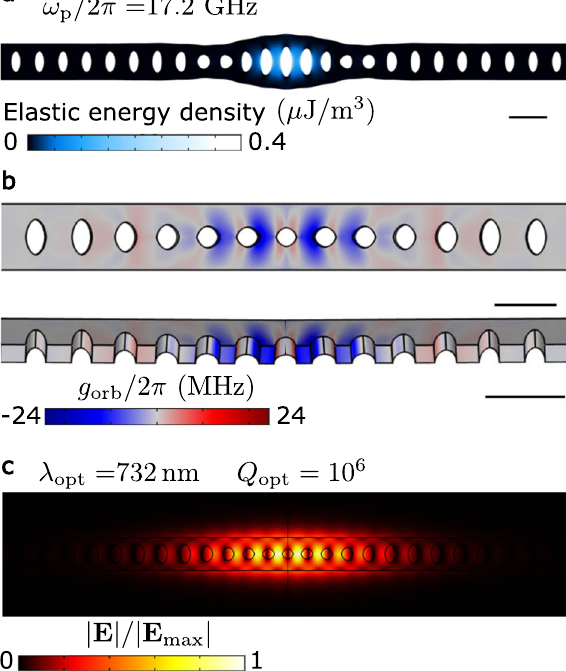
Fig. 3 Diamond optomechanical cavity. a Distribution of elastic energy density of a mode of the diamond cavity resonant at ω p /(2 π ) = 2 GHz. The cavity geometry is arti fi cially distorted along the coordinate of the mechanical mode for emphasis. The energy density is concentrated in the central part of the cavity. b Calculated coupling rate g orb in the phononic cavity. c Normalized amplitude of the optical electric fi eld at vacuum wavelength λ opt = 732 nm of an optical mode of the diamond cavity of an optical quality factor Q opt ≈ 10 6 . The electric fi eld is concentrated around the center of the cavity and thus overlaps with the regions providing high values of g orb . Scale bars: ( a ) 350 nm, ( b ) 350 nm (top), and 500 nm